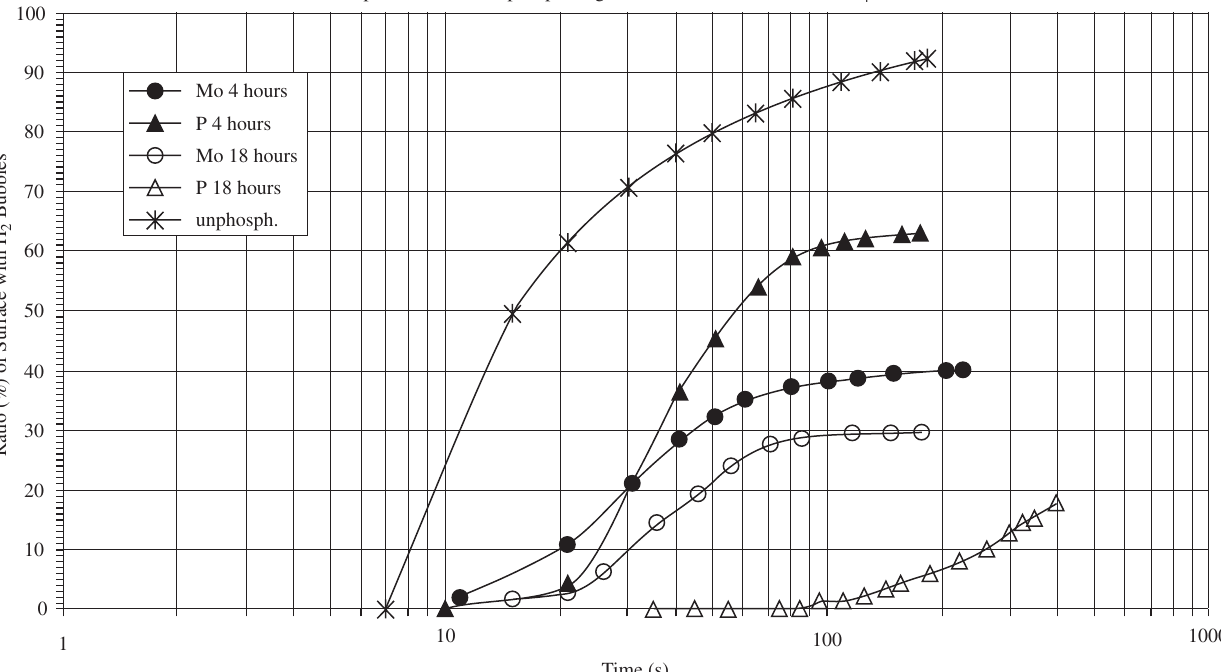
Figure 2. Nd-Fe-B magnet’s surface ratio with H bubbles with time of immersion in dilute HCl solution (pH adjusted to 2). Magnets were tested either un- 2 phosphated or phosphated in solution A (10g/L